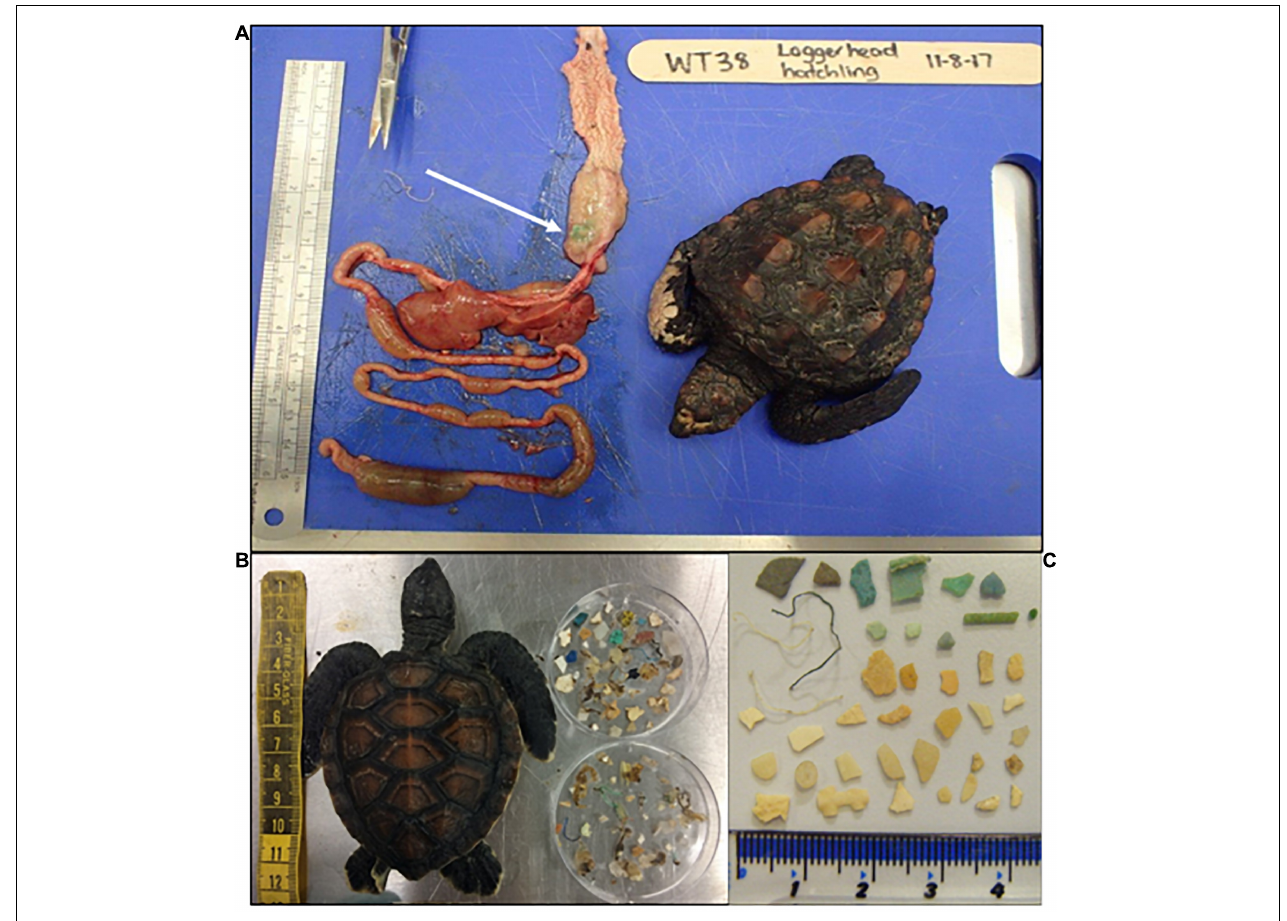
FIGURE 1 | Case studies of plastic ingestion in sea turtles in the Pacific and Indian Ocean (A) Post-hatchling loggerhead turtle found in the Great Southern region of Western Australia in winter (August 2017) and was a suspect cold-stunned case. Twelve pieces of plastic were found on post-mortem including one piece of hard plastic that had caused an impaction in the distal large intestine and likely contributed to morbidity, but was not the primary cause of death (i.e., severe gastrointestinal parasitoses identified on histopathology) (B) stranded post-hatchling green turtle (8.4 cm CCL) from PO with all plastic present in GI tract at necropsy (C) example of ingested plastic from green turtle in PO illustrating that majority hard fragments, scale in